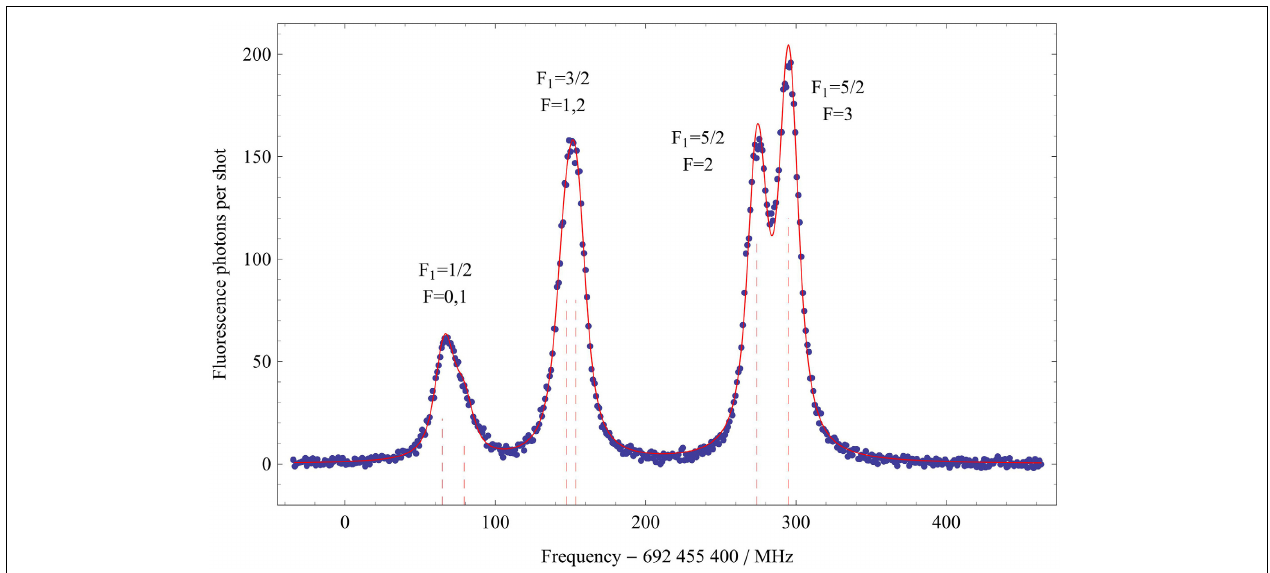
FIGURE 4 | Optical spectrum of the R(0) transition showing the hyperfine structure in the A 1 (cid:2) ( v (cid:2) = 0 , J (cid:2) = 1) state. The solid line is a fit to a sum of six Voigt functions as discussed in the text. The dashed vertical lines show the fitted centers of each component.